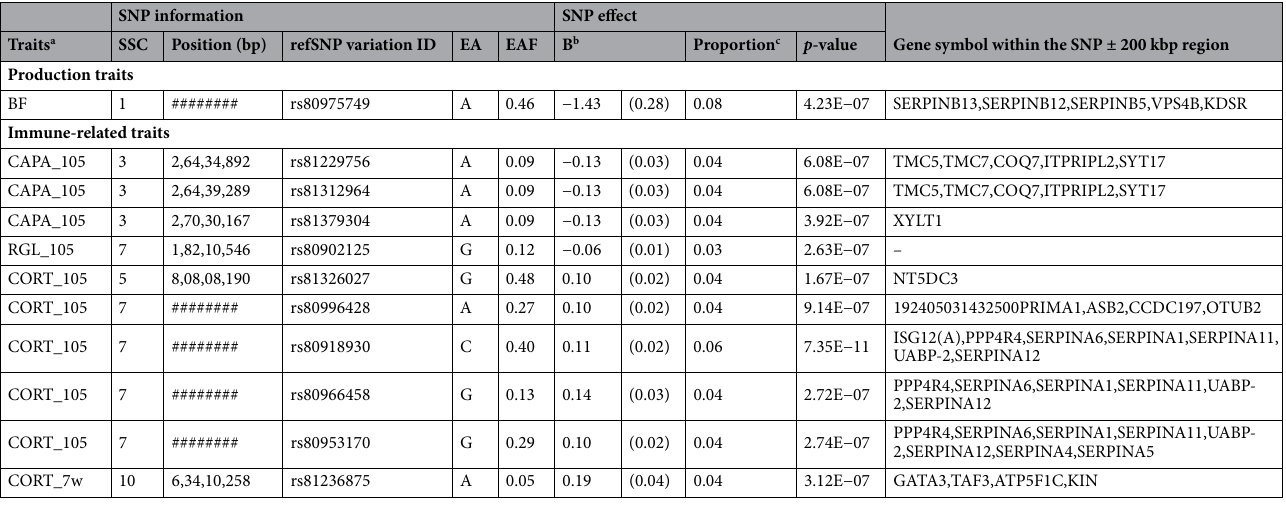
Table 3. The genome-wide significant single nucleotide polymorphisms (SNPs) associated with production and immune-related traits. SSC Sus scrofa chromosome, EA effect allele, EAF effect allele frequency. a Abbreviations of traits are shown in Table 2. b Standard errors are shown in parentheses. c The proportion of adjusted phenotypic variance explained by the SNP effects.